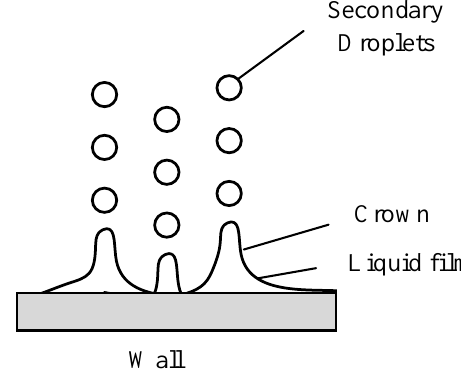
Figure 5. Mechanism of secondary droplet formation.